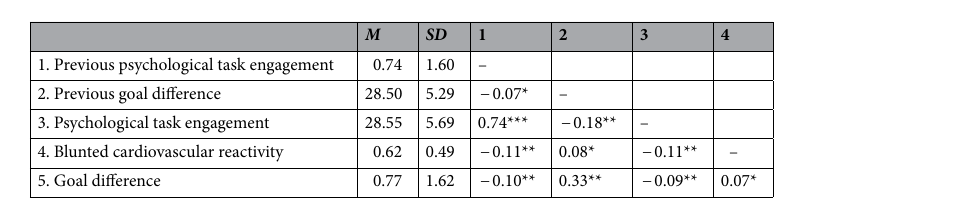
Table 2. Descriptive statistics and correlations among study variables. Mean for blunted cardiovascular reactivity multiplied by 100 indicates the percentage of observations with blunted cardiovascular